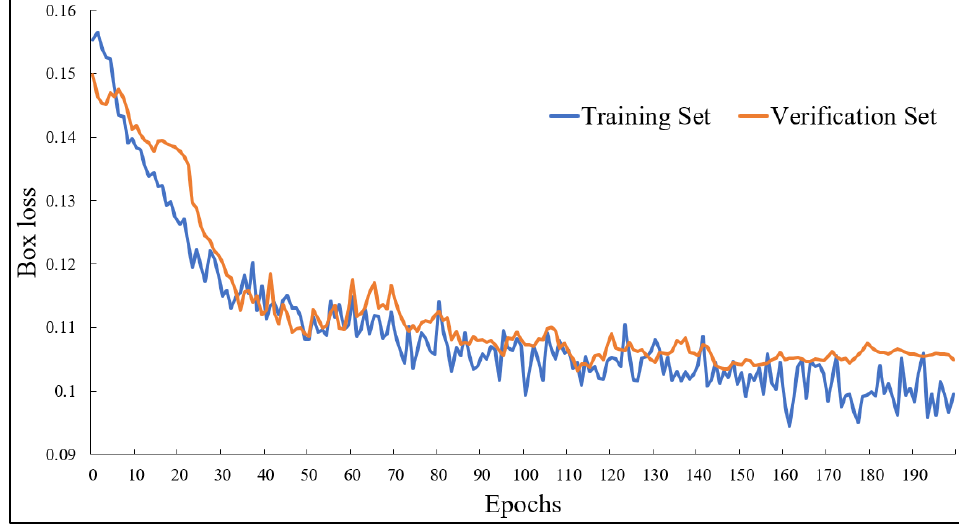
Figure 8. Variation of box loss.